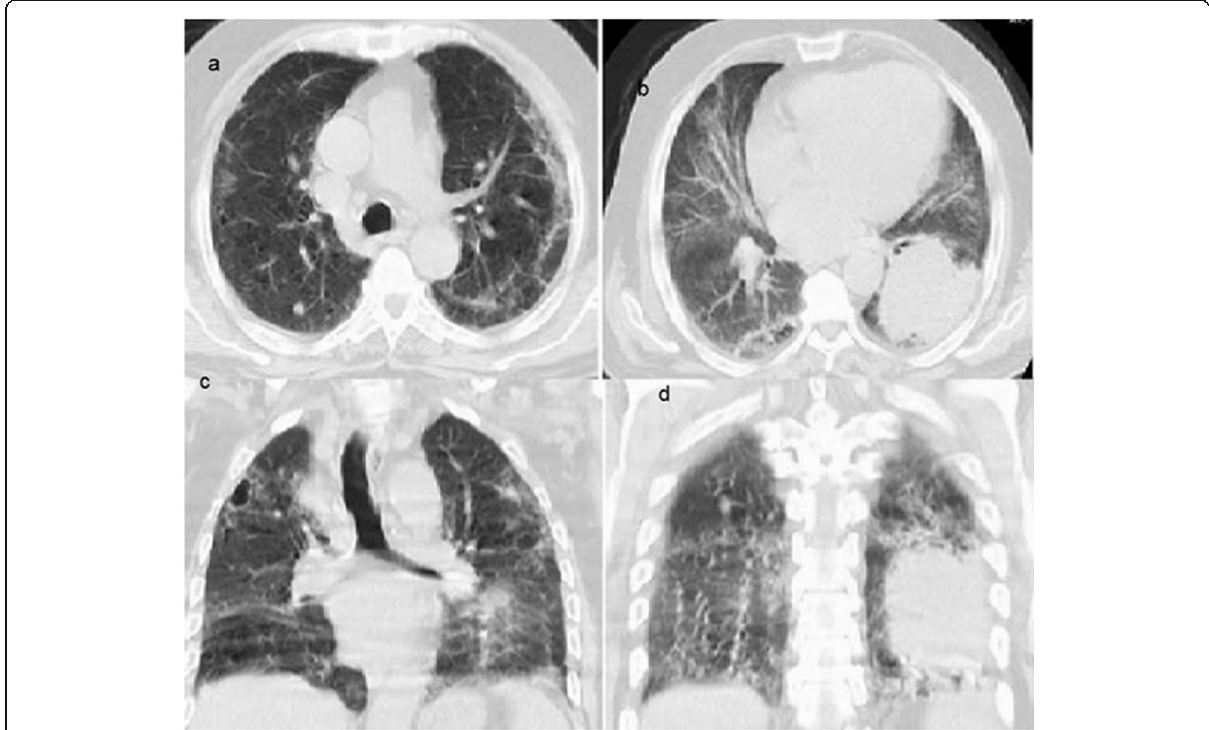
Fig. 3 “ A 63-year-old male patient with a history of prostate cancer. ” MCCT exam revealed a well-defined small solid nodule at the Rt. lower lung lobe and a sizable soft tissue mass lesion at the Lt. lower lung lobe ( a , b ) axial and ( c , d ) coronal images that categorized as the lung-RADS score 4X, “ malignant solid nodular lesions. ” The Lt. side lesion was pathology proved as newly developed adenocarcinoma and Rt. side considered as a metastatic lesion